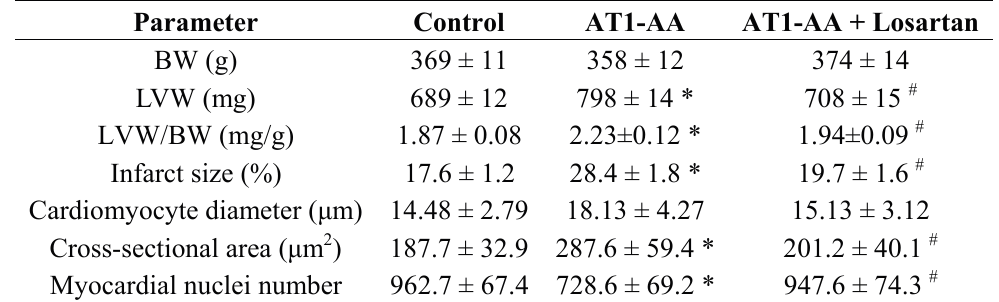
Table 2. Heart weight index and morphometric analysis of LV sarcomeres and mitochondria of rats. LVW: left ventricular weight; BW: body weight.